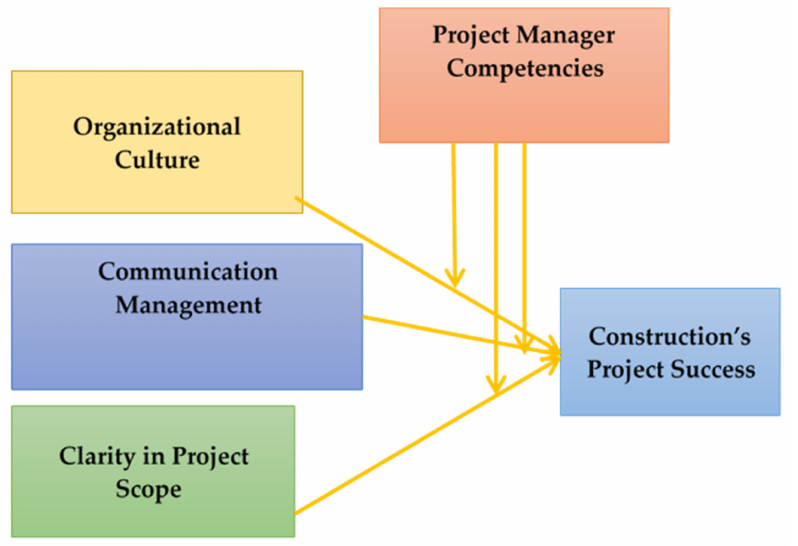
Figure 1. Conceptual framework.